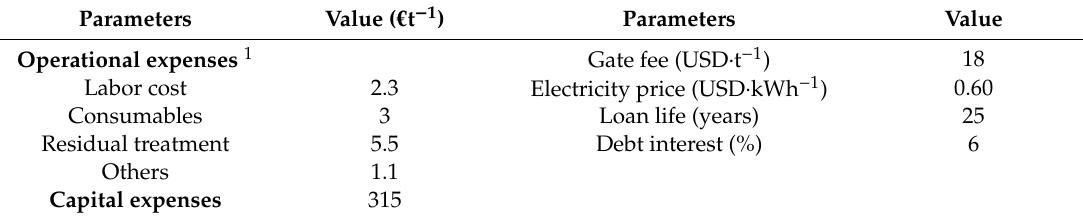
Table 7. Parameters considered in the financial